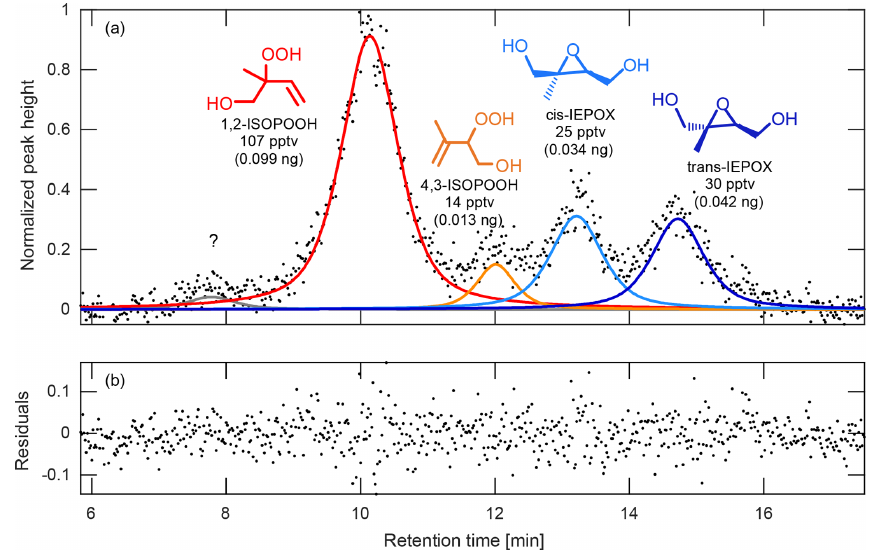
Figure 6. (a) Chromatogram, peak fits, and (b) resulting fit residuals obtained from the peak-fit MATLAB function for the deconvolution and integration of ambient ISOPOOH and IEPOX isomers observed during the PROPHET 2016 field study. The isomers observed during this study were 1,2-ISOPOOH (red), 4,3-ISOPOOH (orange), cis-IEPOX (light blue), and trans-IEPOX (dark blue). In addition, an unknown peak (gray) can be seen eluting at 7.8min prior to the ISOPOOH and IEPOX isomer species. To obtain the ambient mixing ratios, peaks are deconvoluted and integrated using an appropriate peak shape (in this case, a Gaussian–Lorentzian blend), scaled by the relative CIMS sensitivities of each isomer (see Supplement), ion source enhancement (if applicable), and estimated transmission factor, and then normalized by volume of air collected on the column. The GC signal shown here has been normalized to the largest peak height. Amounts shown in parentheses correspond to the amount of analyte trapped in the